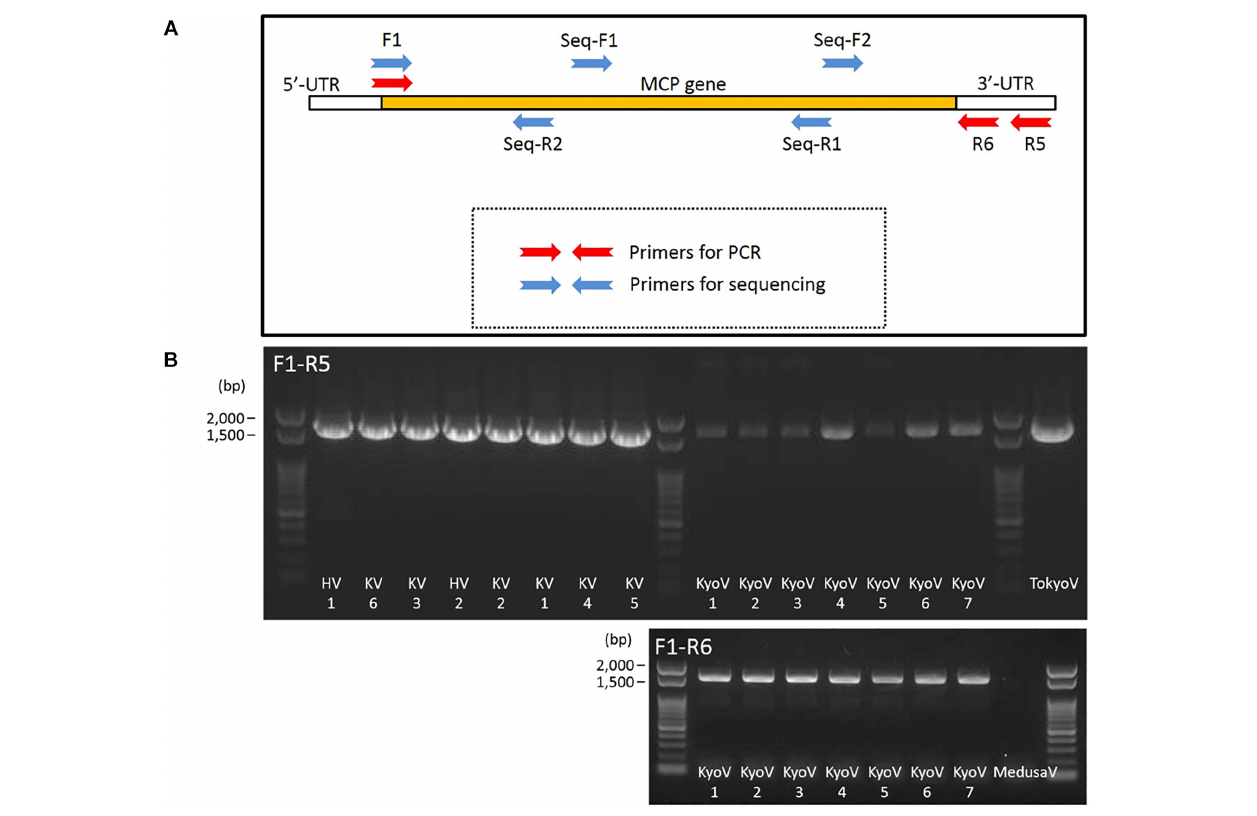
FIGURE 6 | Primers for MCP genes of the family Marseilleviridae . (A) Design outline of primers for amplification of MCP genes of the family Marseilleviridae and 4 primers for sequencing. (B) PCR products of MCP genes of kashiwazakiviruses (KV), hokutoviruses (HV), and kyotoviruses (KyoV), using 2 sets of primers, F1-R5 and F1-R6. Tokyovirus (TokyoV) and medusavirus (MedusaV) were used as positive and negative controls,